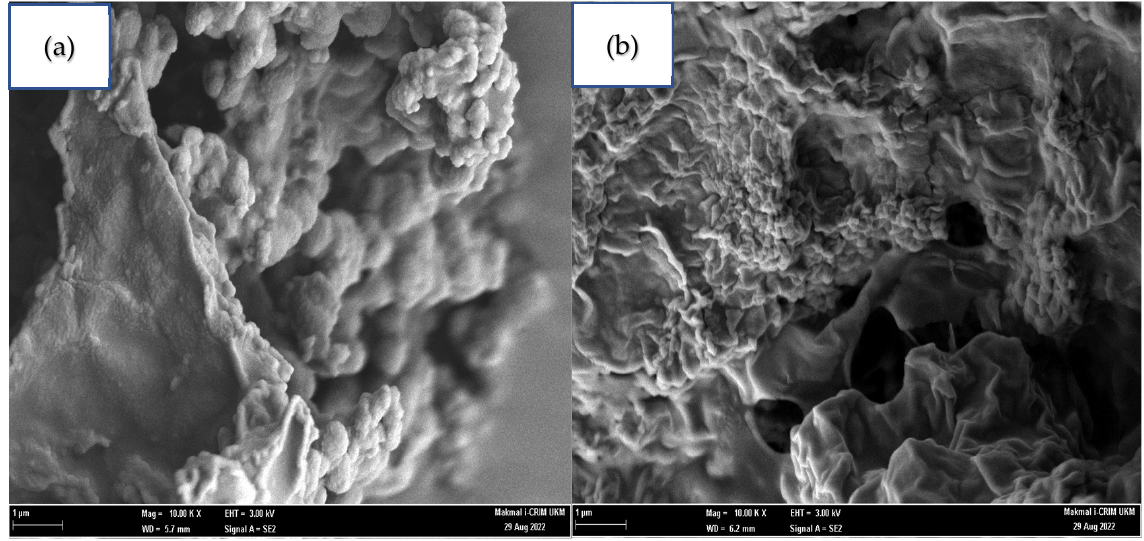
Figure 6. FESEM image under 10 K magnification power of ( a ) Glycerol-SO 3 H, ( b ) Glycerol-ClSO 3 H.